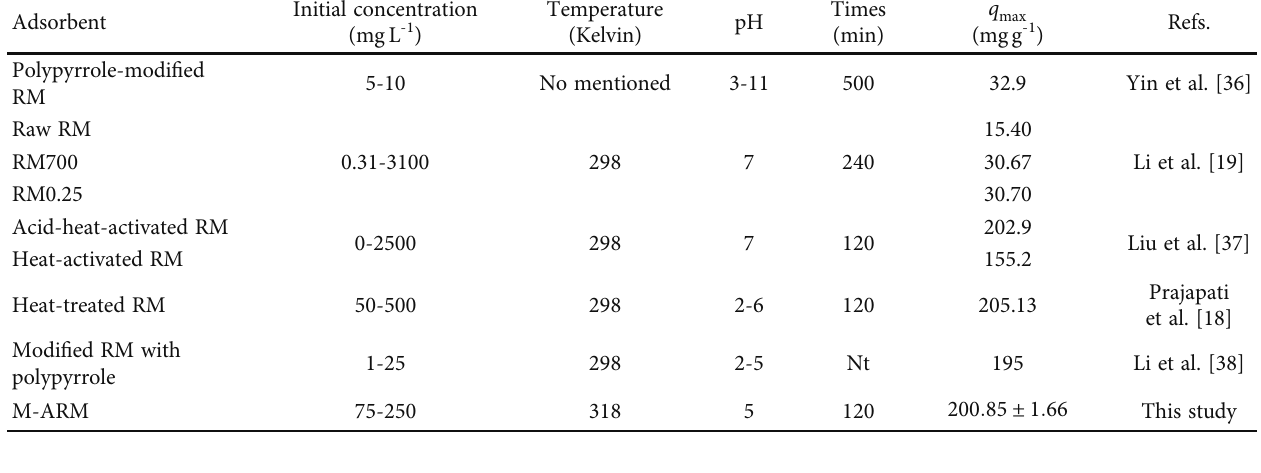
Table 7: Compared with the results of other studies.